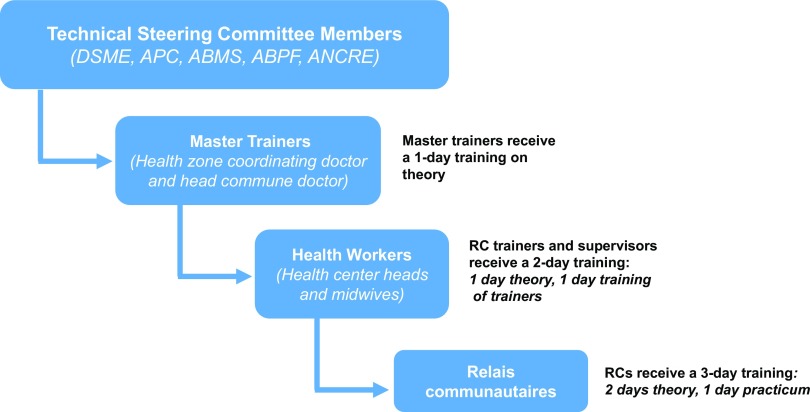
DMPA-SC Cascade Training ProcessAbbreviations: ABMS, Benin Association for Social Marketing and Communication for Health; ABPF, Association Béninoise pour la Promotion de la Famille; ANCRE, Advancing Newborn, Child, and Reproductive Health; APC, Advancing Partners & Communities; DMPA-SC, subcutaneous depot medroxyprogesterone acetate; DSME, Maternal and Child Health Directorate; RCs, relais communautaires (lay community health workers).